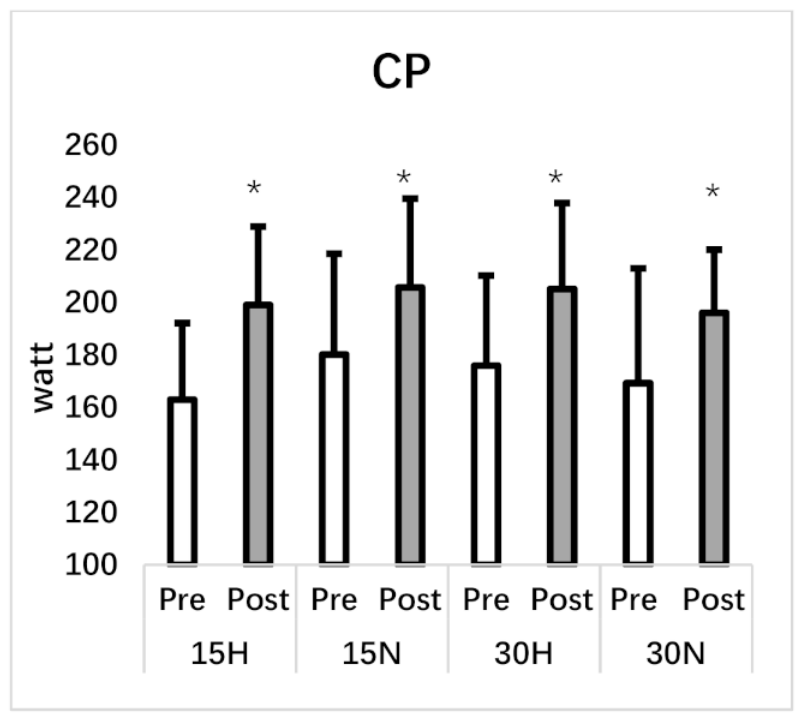
Figure 5. Critical power test. CP: critical power, *: significant difference between pre and post